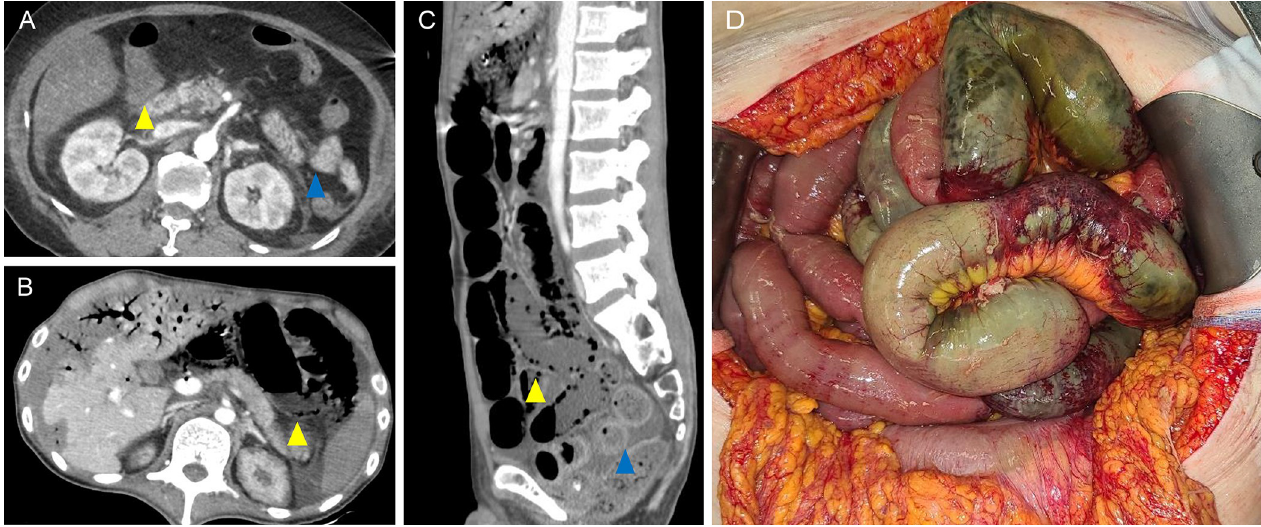
Fig 2. Contrast-enhanced CT images and intraoperative bowel images of non-occlusive mesenteric ischemia. (A) Contract-enhanced abdomen CT images of survivor, transverse image (B) Contract-enhanced abdomen CT images of non-survivor, transverse image (C) Contract-enhanced abdomen CT images of non-survivor, sagittal image (D) intraoperative bowel images; multiple segmental bowel necrosis was observed, but also normal bowel and mesentery found between necrotic bowel segments. Yellow arrows indicate the dilated and thinned bowel and blue arrows indicate normal bowel.